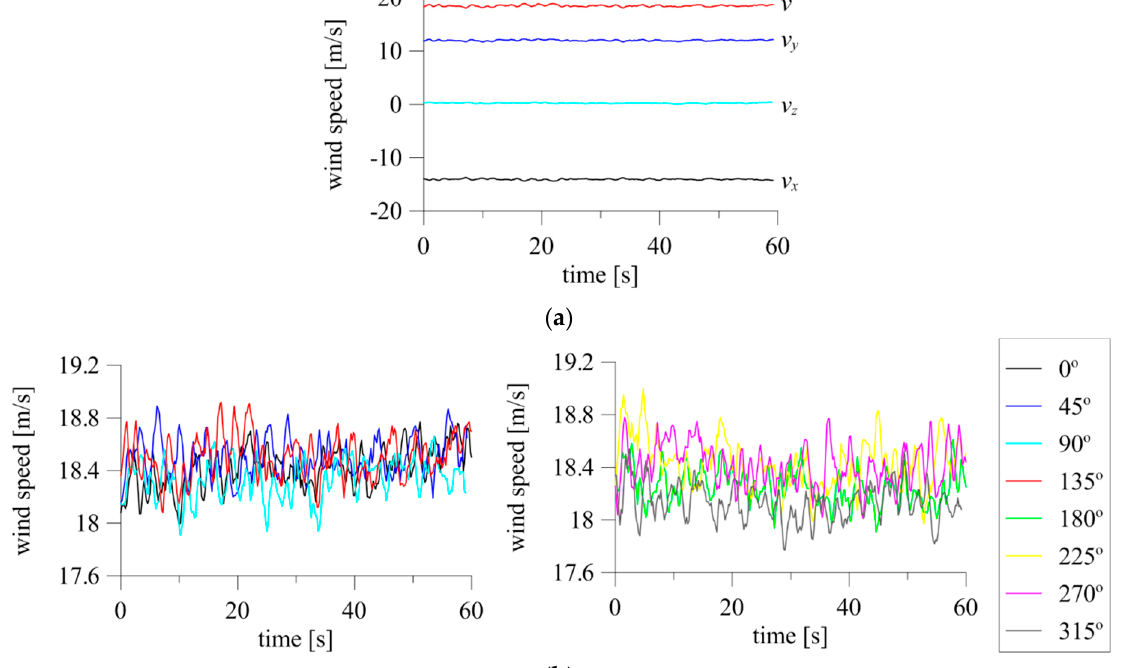
Figure 9. Fluctuations of wind speed: ( a ) components and resultant, for α = 135°; ( b ) resultant for all angles.